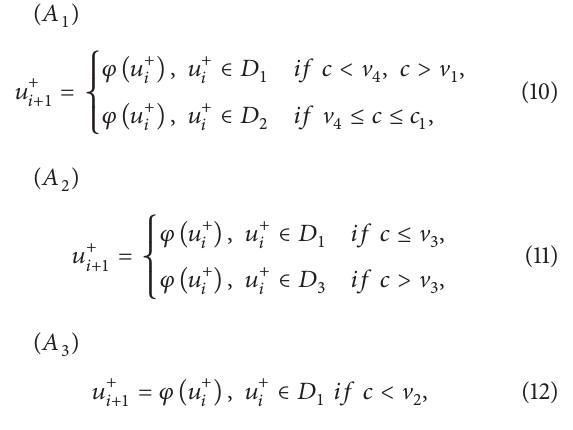
effect. Therefore, if both points 𝑝 + 𝑖 and 𝑝 𝑖+1 lie in the same trajectory Γ for 𝑖 = 1, 2, . . . , 𝑘 , then the point 𝑝 𝑖+1 is only determined by 𝑝 + 𝑖 ; that is, 𝑢 𝑖+1 can be only determined by 𝑢 + 𝑖 , which can be expressed by 𝑢 𝑖+1 = 𝑔(𝑢 + 𝑖 ) . Clearly, function